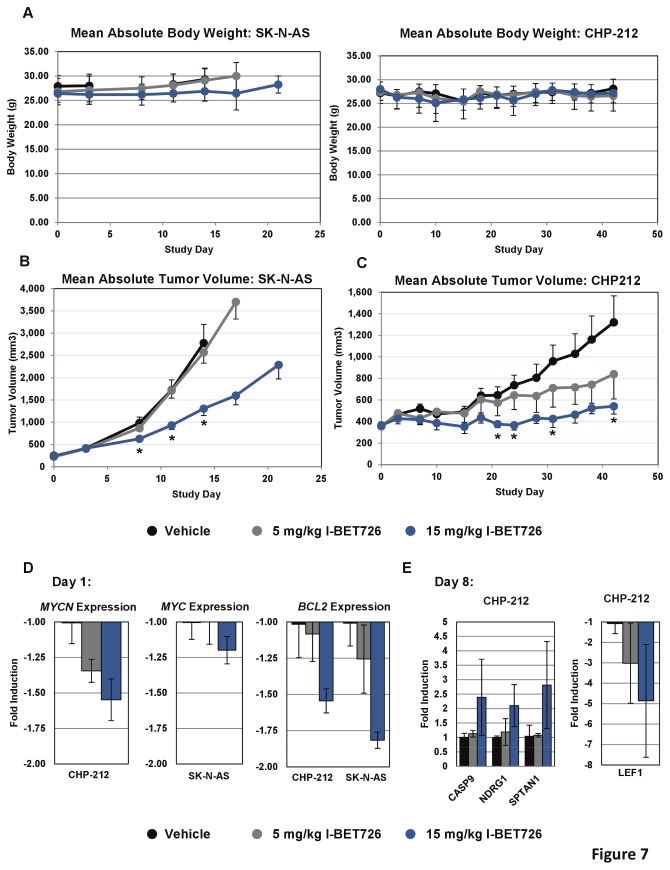
Analysis of I-BET726 activity in vivo.(a) Mean absolute body weight ± SD for mice in the SK–N-AS (left) and CHP-212 (right) xenograft studies treated with vehicle, 5 mg/kg, or 15 mg/kg I-BET726. (b) Mean absolute tumor volumes ± SEM for SK–N-AS subcutaneous xenografts following treatment with 5 mg/kg or 15 mg/kg I-BET726. Asterisks indicate statistical significance as measured by t-test (p <0.05). Tumor growth inhibition (TGI) for the 15 mg/kg group was 58% on day 14 (n= 9; p= 0.0060). (c) Mean absolute tumor volumes ± SEM for CHP-212 subcutaneous xenografts following treatment with 5 mg/kg or 15 mg/kg I-BET726. Asterisks indicate statistical significance as measured by T-test (p <0.05). TGI for 5 mg/kg was 50% on Day 42 (n= 8; p= 0.1816). TGI for 15 mg/kg was 82% on Day 42 (n=5; p =0.0488). (d) Pharmacodynamic analysis in CHP-212 and SK–N-AS xenografts 8 hours after initial dose of I-BET726. qRT-PCR analysis of MYCN, MYC, and BCL2 expression following I-BET726 treatment in the indicated models. Data is presented as fold induction compared to vehicle treated controls, and represents the average ± SD of data from three animals. (e) qRT-PCR analysis of apoptotic pathway and N-Myc pathway genes in CHP-212 xenografts 8 hours following treatment with I-BET726 on day 8 of study. Data is presented as described in (d).